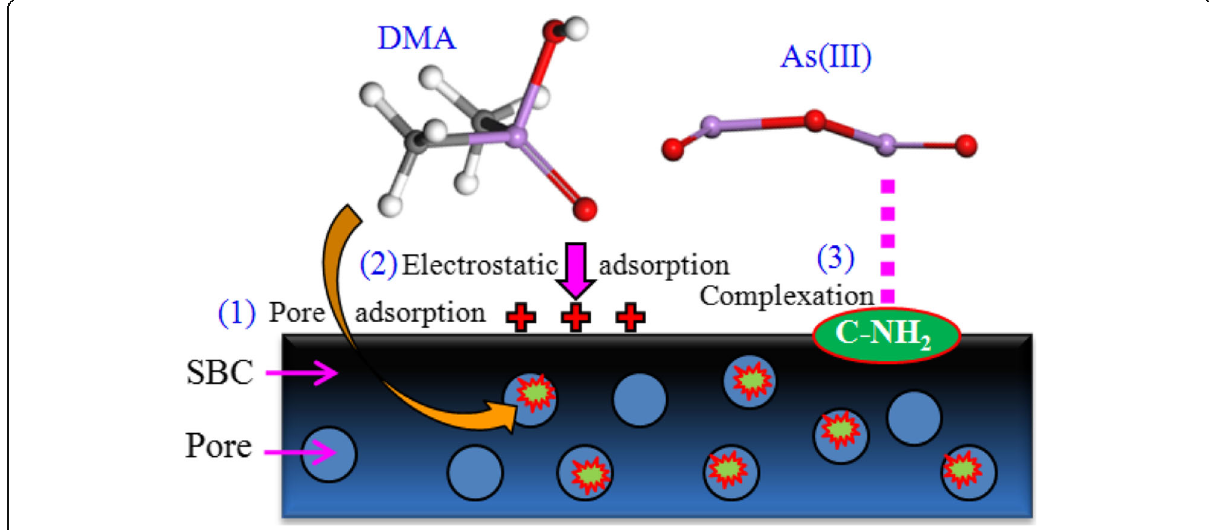
Fig. 12 The schematic diagram of mechanism for arsenate adsorption on DETA-SBC